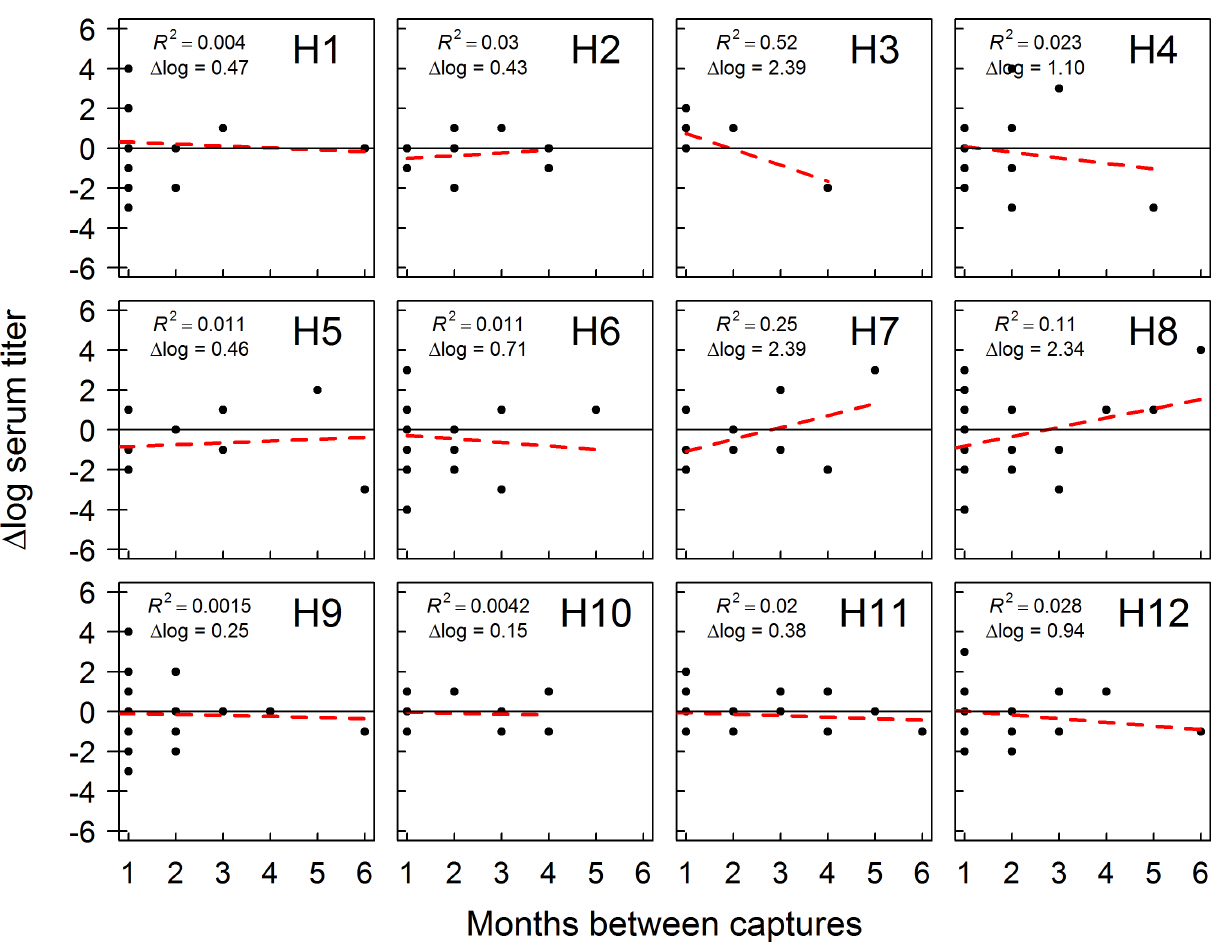
Fig 5. Trends in antibody production to influenza A viruses (IAVs) by mallards sampled in Anchorage, Alaska. Mallardswere captured and sampled from September through April of 2014/15. Analysis includedsamplesobtainedfrom individuals determined to be seropositive upon multiplecapture occasionswith bELISA. Time intervals on the x-axis represent the number of months betweenfirst and one randomlyselectedcapture occasion. The dashed red line representsa linear regressiontrend line and associatedR-squared